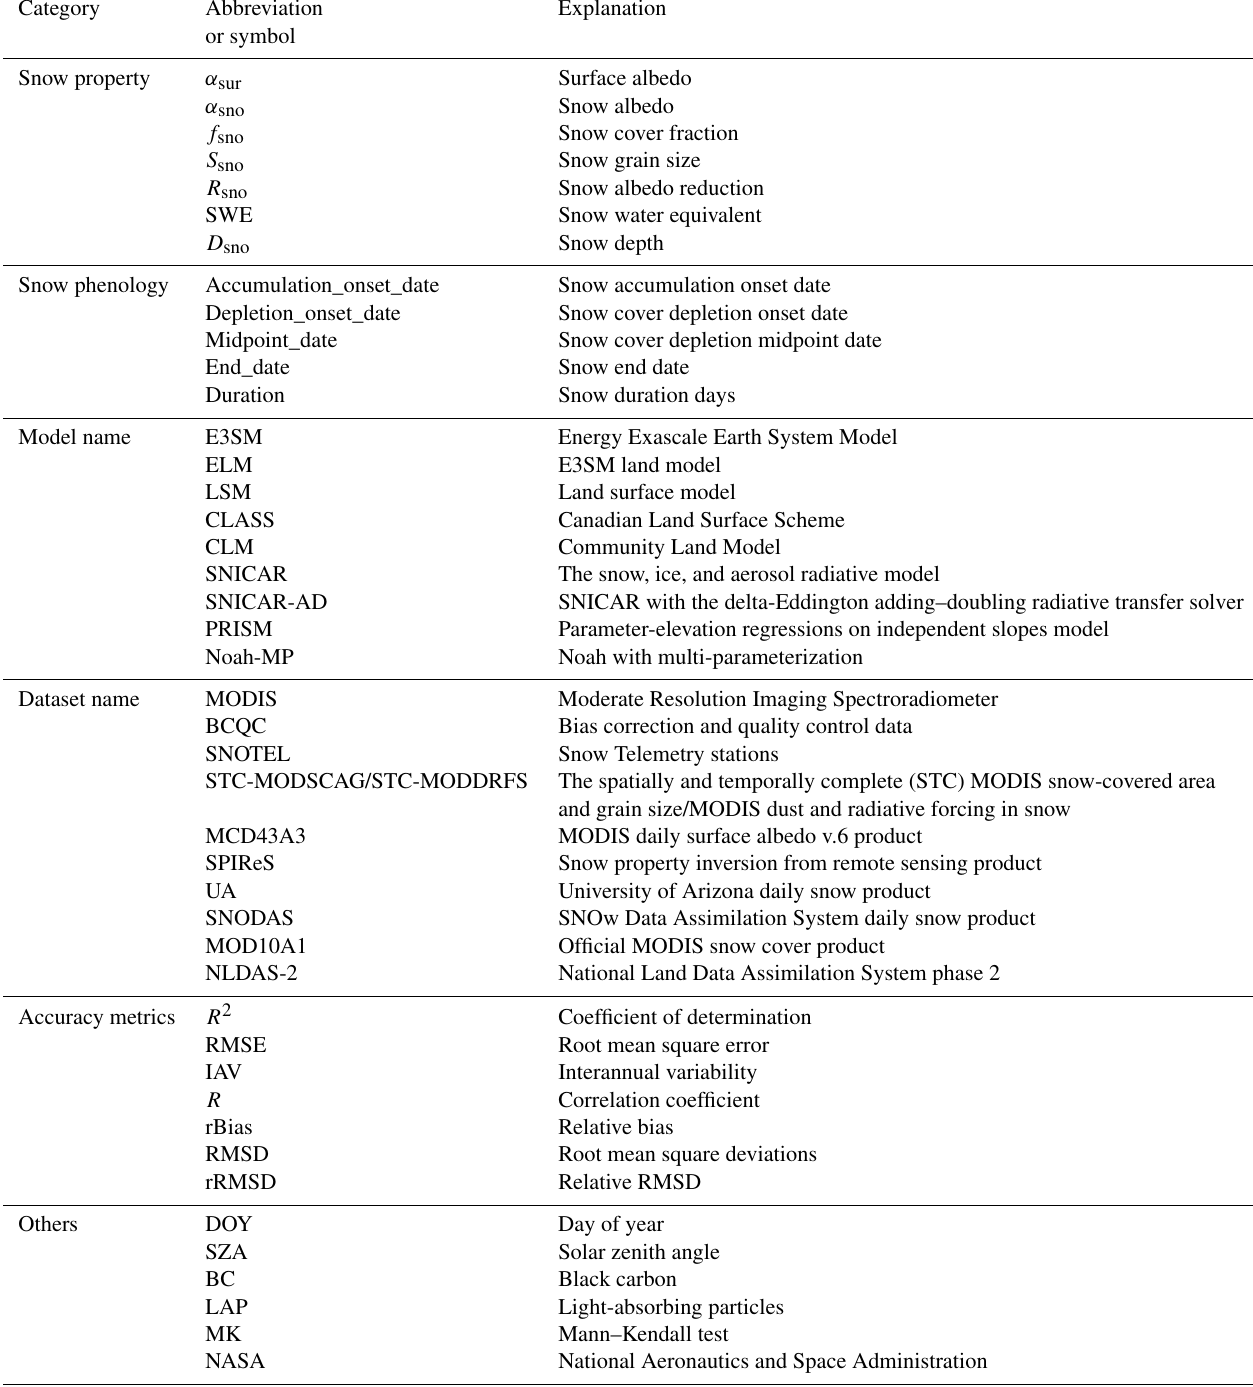
Table A1. The acronyms and symbols used in the